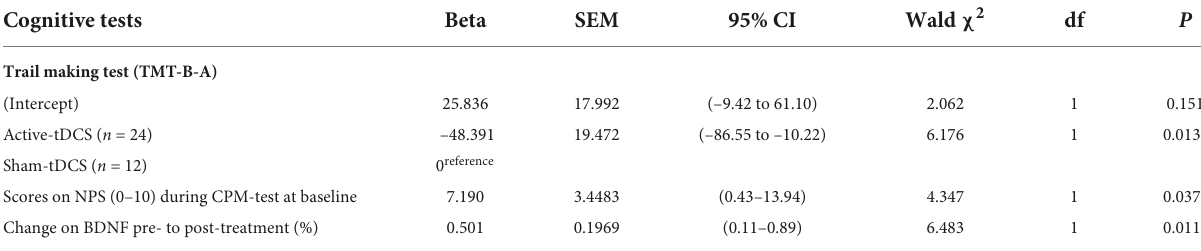
TABLE 3 Effect of treatment on TMT-B-A (primary outcome).